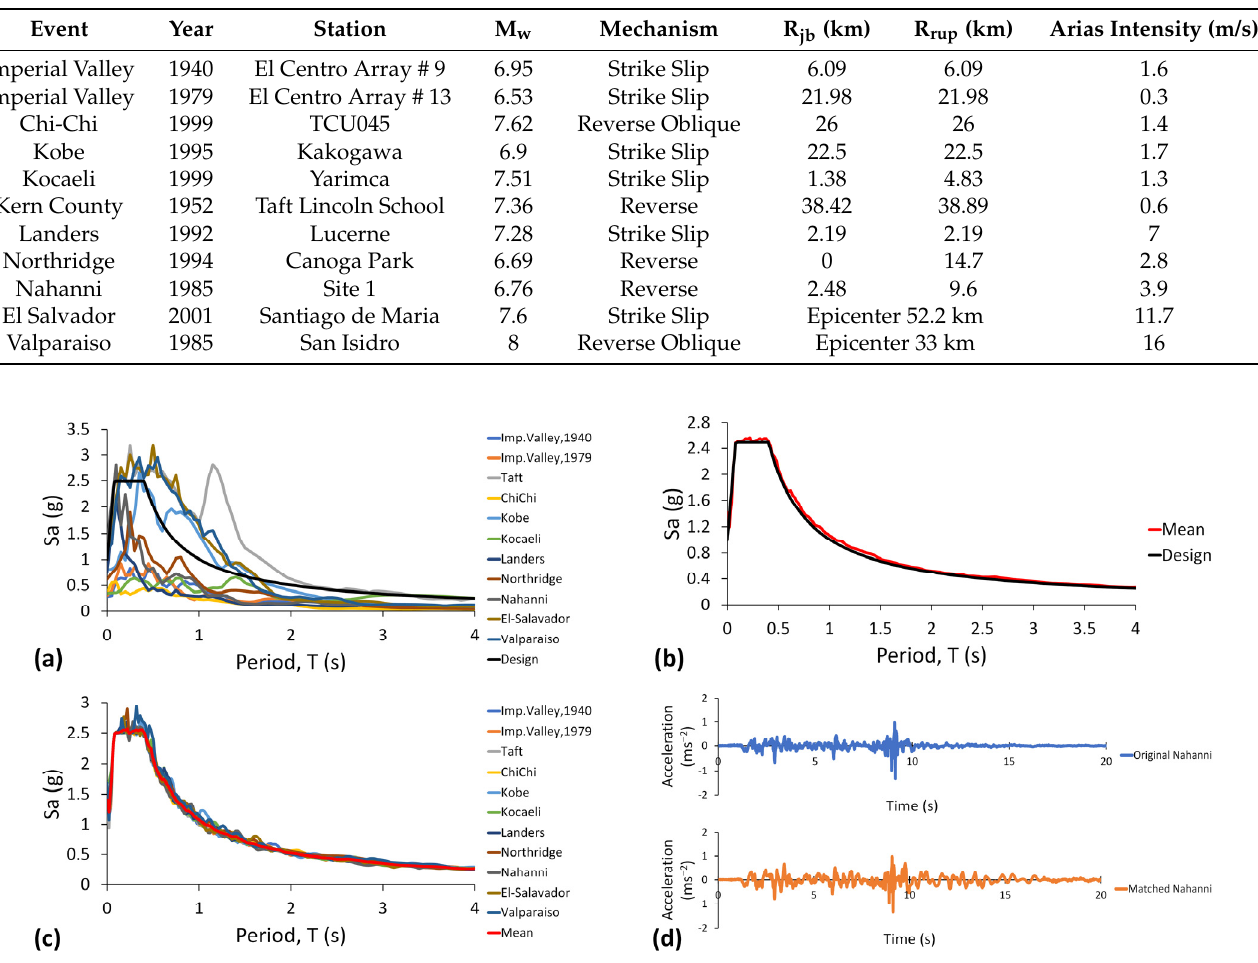
Table 1. Selected Ground Motions.